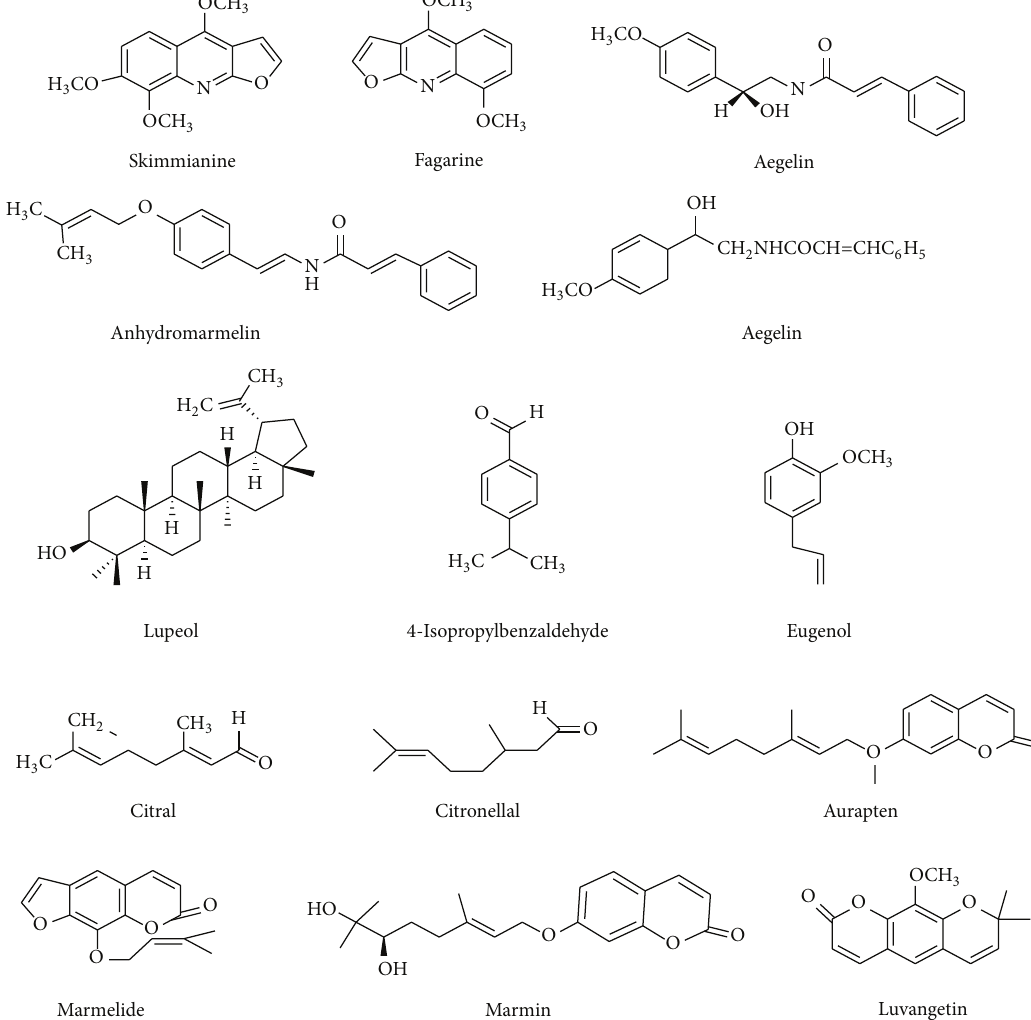
Figure 1: Structures of various bioactive compounds present in Aegle marmelos